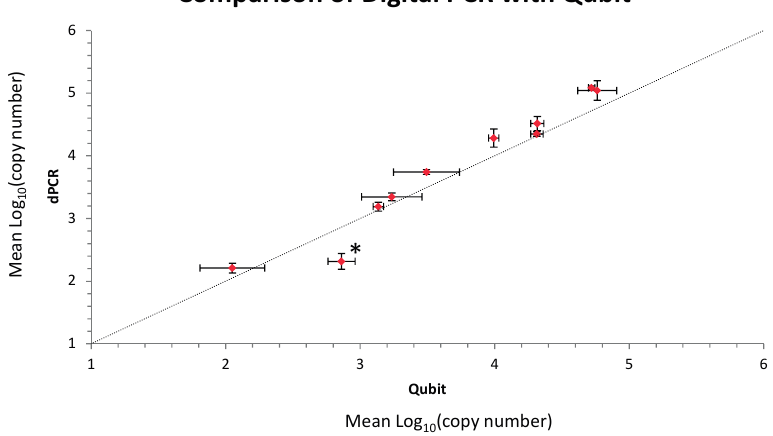
Figure 1. X / Y plot comparing the mean log 10 (copy number) of each of the bacterial gDNA’s as estimated by the Qubit fluorometer and digital PCR (dPCR). The asterix indicate significance using t -test and Bonferroni correction. Error bars indicate 95% confidence intervals. The slope is significantly different than zero ( p value < 0.000002) but not significantly different from 1 ( p value: